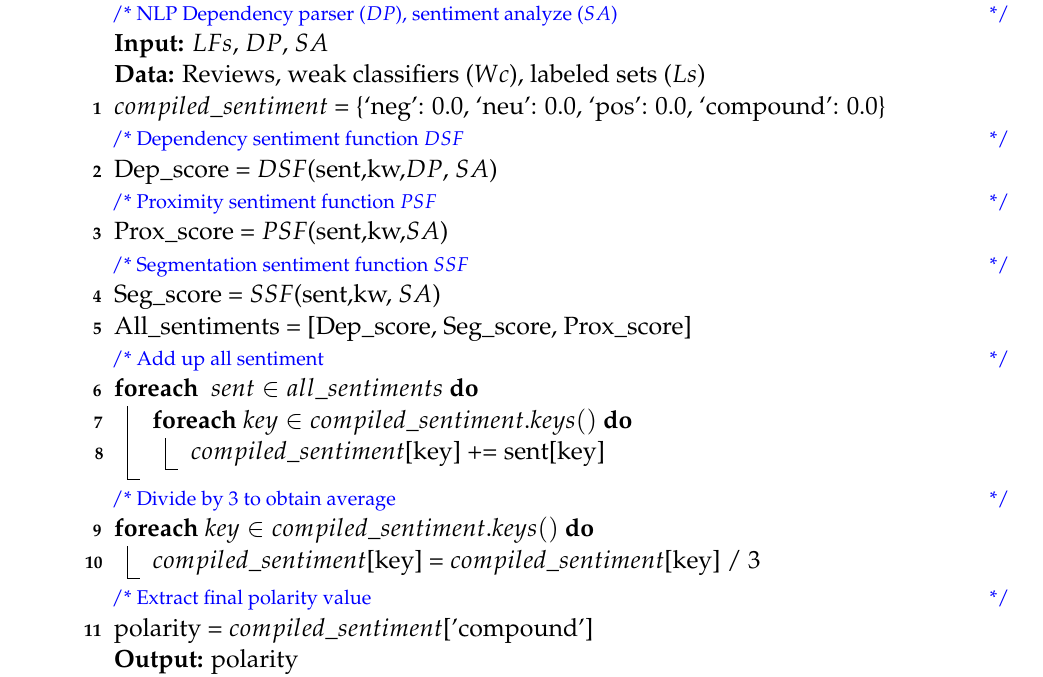
Algorithm 2: Sentiment Aggregation